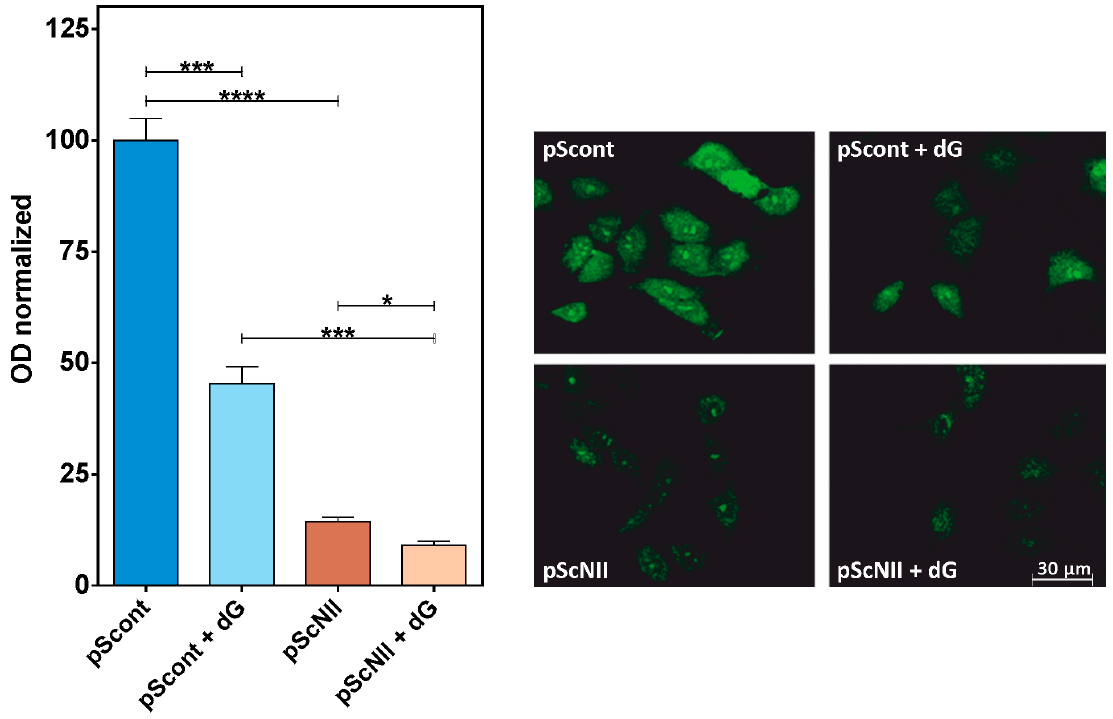
Figure 6. Effect of cN-II silencing on protein synthesis in A549 cells. Newly synthetized proteins were labeled using the Click-iT ® HPG Alexa Fluor Protein Synthesis kit (see Methods for details). The incorporation of the methionine analogue HPG was monitored with confocal microscopy. Left : optical density (OD) of the fluorescence signal generated by Alexa Fluor 488-azide crosslinked to HPG in A549 cells pScont and pScNII with or without 20 mM dG. Results are the mean + SEM of three independent experiments. * p < 0.05, *** p < 0.001, **** p < 0.0001. Right : confocal images of A549 cells after HPG incorporation and Alexa Fluor 488-azide reaction. Calibration bar = 30 µ m applies to all micrographs.